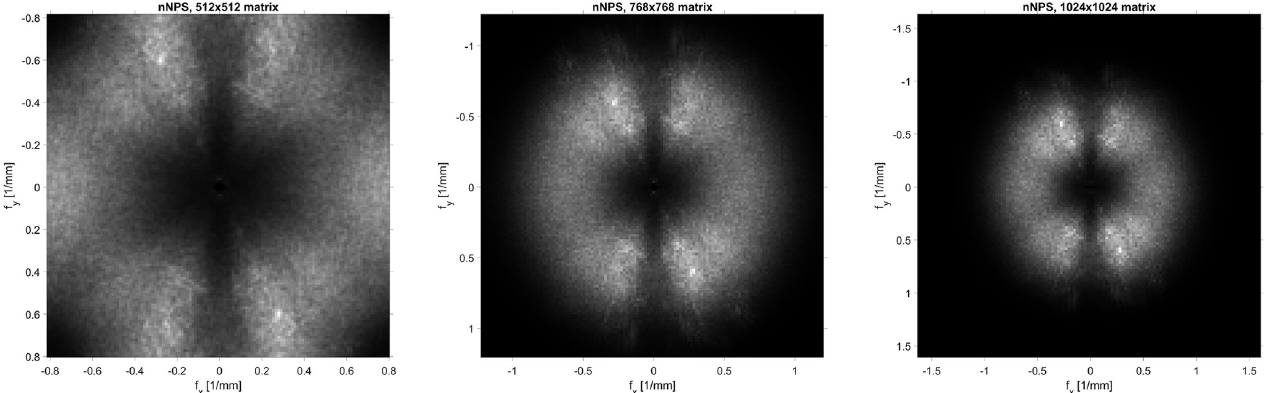
Fig 4. Shape of the 2D nNPS. Comparison of the shape of the 2D nNPS among all three matrix sizes. The shape for the 512-matrix demonstrated distortion, indicating aliasing effects. The diagonal 1D profile of the 2D nNPS was not affected by distortion and was therefore used as a non-biased metric to compare the noise